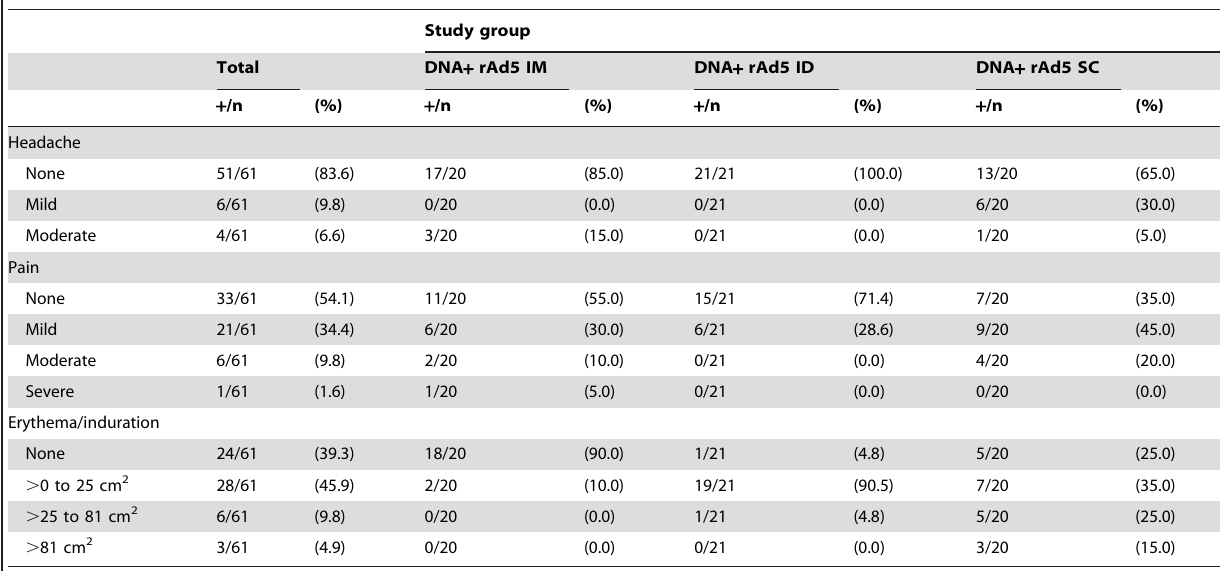
Table 2. Reactogenicity after rAd5 boost by study